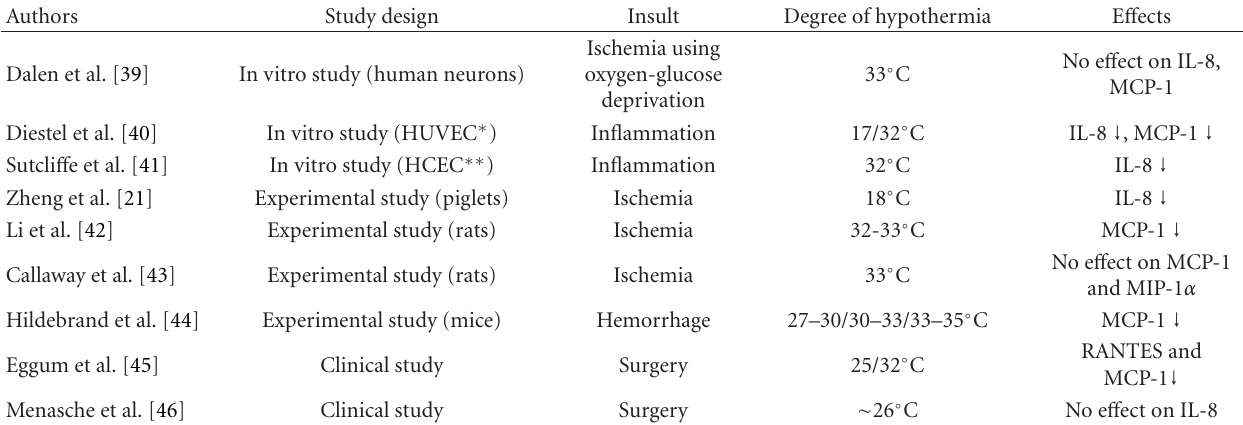
Table 4: E ff ects of hypothermia on chemokines.